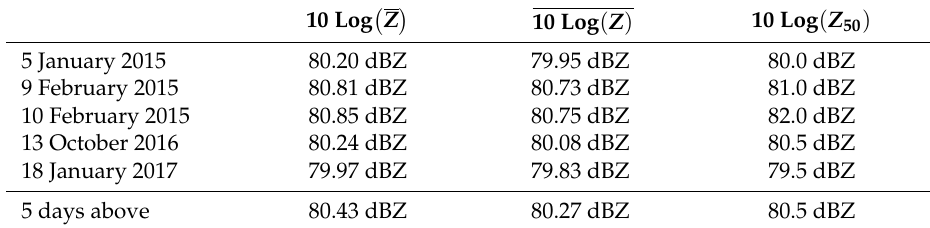
Table 3. Same as Table 2, but for the vertical polarization.